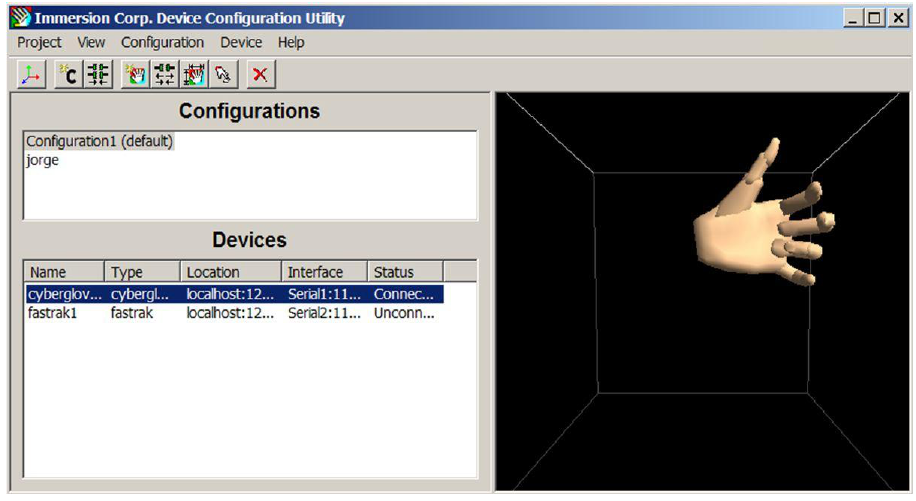
Figure 6. Data Glove Initialization